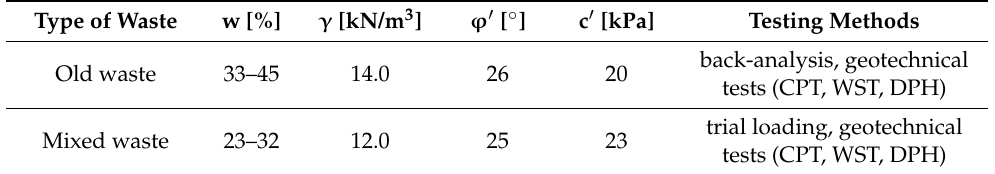
Table 1. Geotechnical parameters of wastes deposed in the landfill. Type of Waste w [%] γ [kN/m 3 ] ϕ (cid:48) [ ◦ ] c (cid:48) [kPa] Testing Methods Old